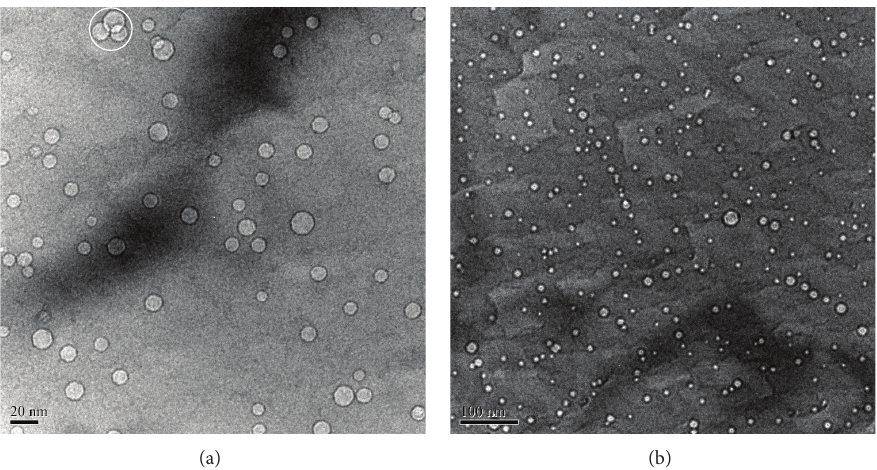
Figure 5: TEM micrographs of the irradiated Al-B metal tempered at 700 ∘ C for about 1 h.